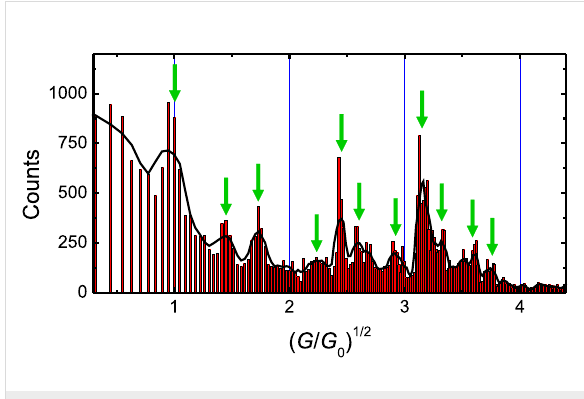
Figure 3: Conductance histogram for electrochemically deposited atomic-scale silver contacts giving evidence for the crossover from electronic-shells to geometric-shell configurations. The histogram was obtained from more than 36600 conductance levels in the range between 0.01 G 0 and 19.9 G 0 , each longer than 200 ms. The x -axis is plotted as a function of the square root of conductance in units of G 0 = 2 e 2 /h, which is proportional to the contact radius R according to the Sharvin equation (see text). The solid line gives the two-neighbor average of the histogram data, which is used to identify the position of the maxima (marked by